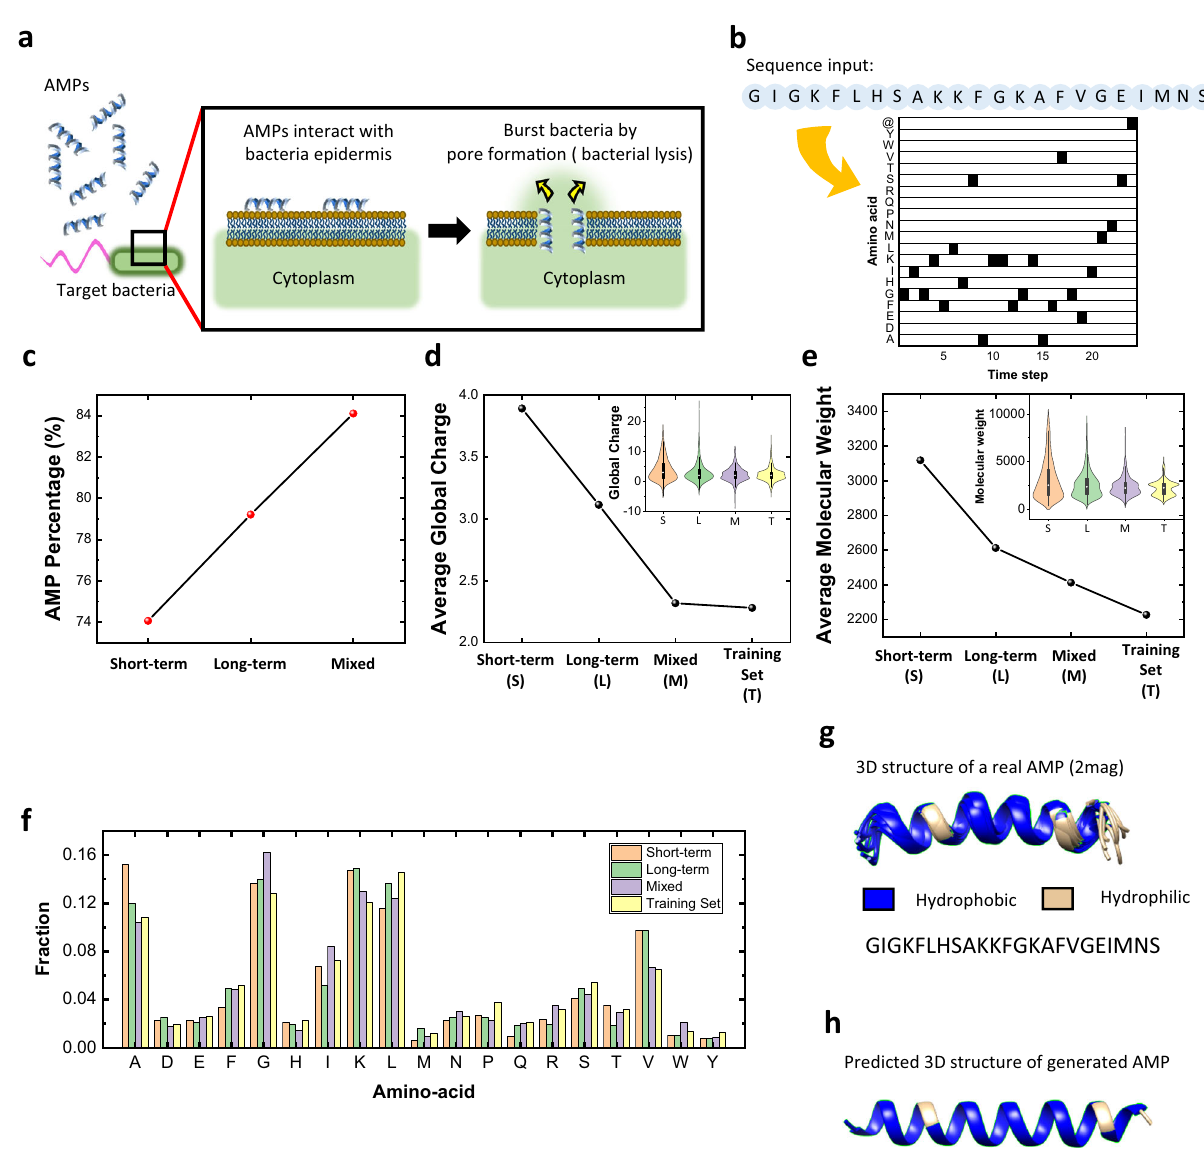
Fig. 5 Schematic of the antimicrobial operation mechanism of AMP and the evaluation of generated AMP sequences. a AMPs bursting the bacteria epidermis by pore formation. b An illustration of the transformation of an input sequence into a 20-dimensional vector (or 20 channels) with 24-time steps, where 20 is the number of the unique amino-acids in the input sequence with the added end cursor “ @ ” , and 24 is the length of the sequence after adding the end cursor. c The percentage of AMP sequences in the generation set from short-term (low W/I ratio), long-term (high W/I ratio), and mixed case (various W/I ratios), respectively. d Average global charge from each sequence set. The mixed case shows a similar global charge value to the training set, while the others do not. Inset: the total global charge value of the entire sequences in each set. e Average molecular weight from each sequence set. The mixed case generates sequences that have similar weights to the training set. Inset: the total molecular weights of all of the sequences. f Amino-acid distribution of each sequence set. g The 3D image of an AMP (protein data bank ID: 2mag 44 ) in the training set. h A predicted 3D image of the generated AMP from the mixed case neuro-memristive computing